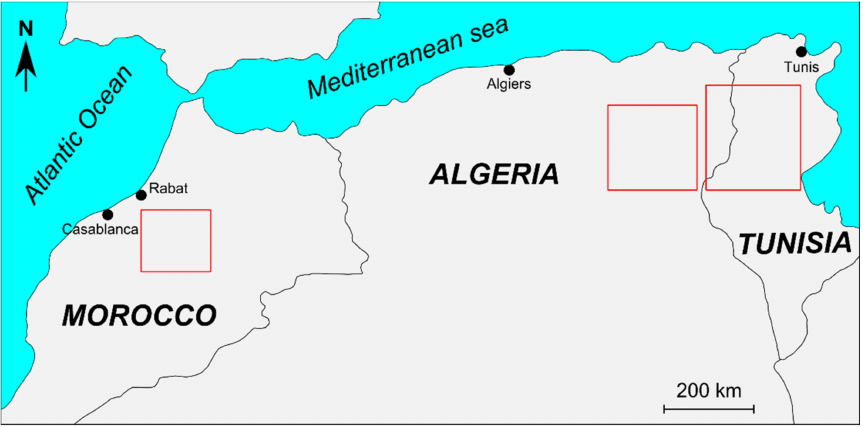
Figure 1. Geographical schema displaying the northern Africa sector where the studied phosphorite deposits (red boxes) are